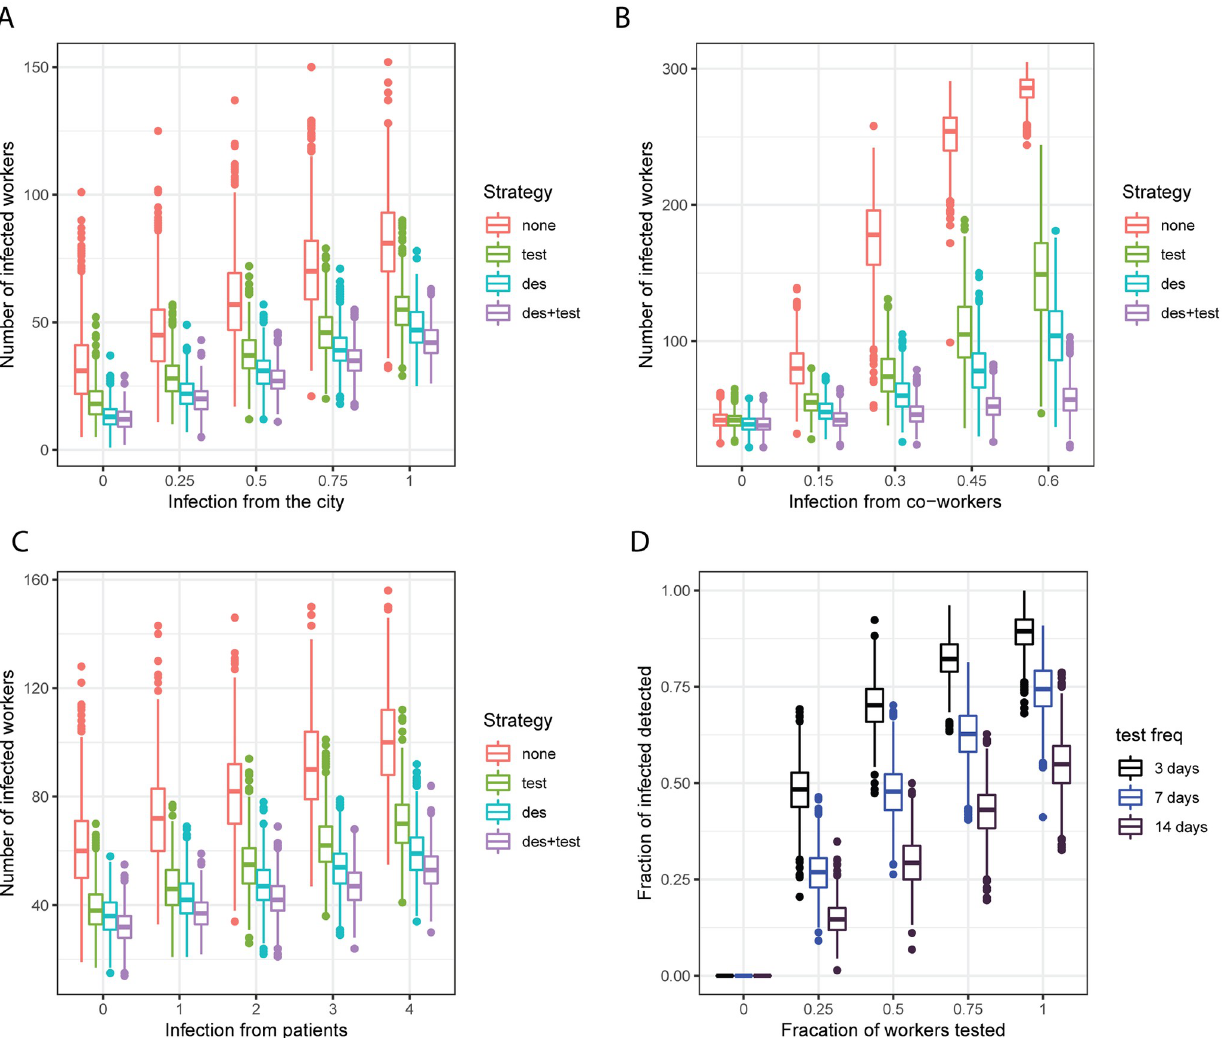
Fig 3. Effect of the protective measures. (A) Number of infected healthcare workers at the end of a simulation for different values of a for the different strategies (none, test, desynchronisation and test+desynchronisation); β = 0.15, γ = 2. (B) Number of infected healthcare workers at the end of a simulation for different values of β for the different strategies; γ = 2, a = 1. (C) Number of infected healthcare workers at the end of a simulation for different values of γ for the different strategies; β = 0.15, a = 1. (D) Fraction of detected cases in as a function of the fraction of workers being tested for different intervals of testing; β = 0.15, γ = 2, a = 1. Parameters β and γ are in units of days − 1 . test: testing strategy; des: desynchronization strategy, des+test: combining testing and desynchronization